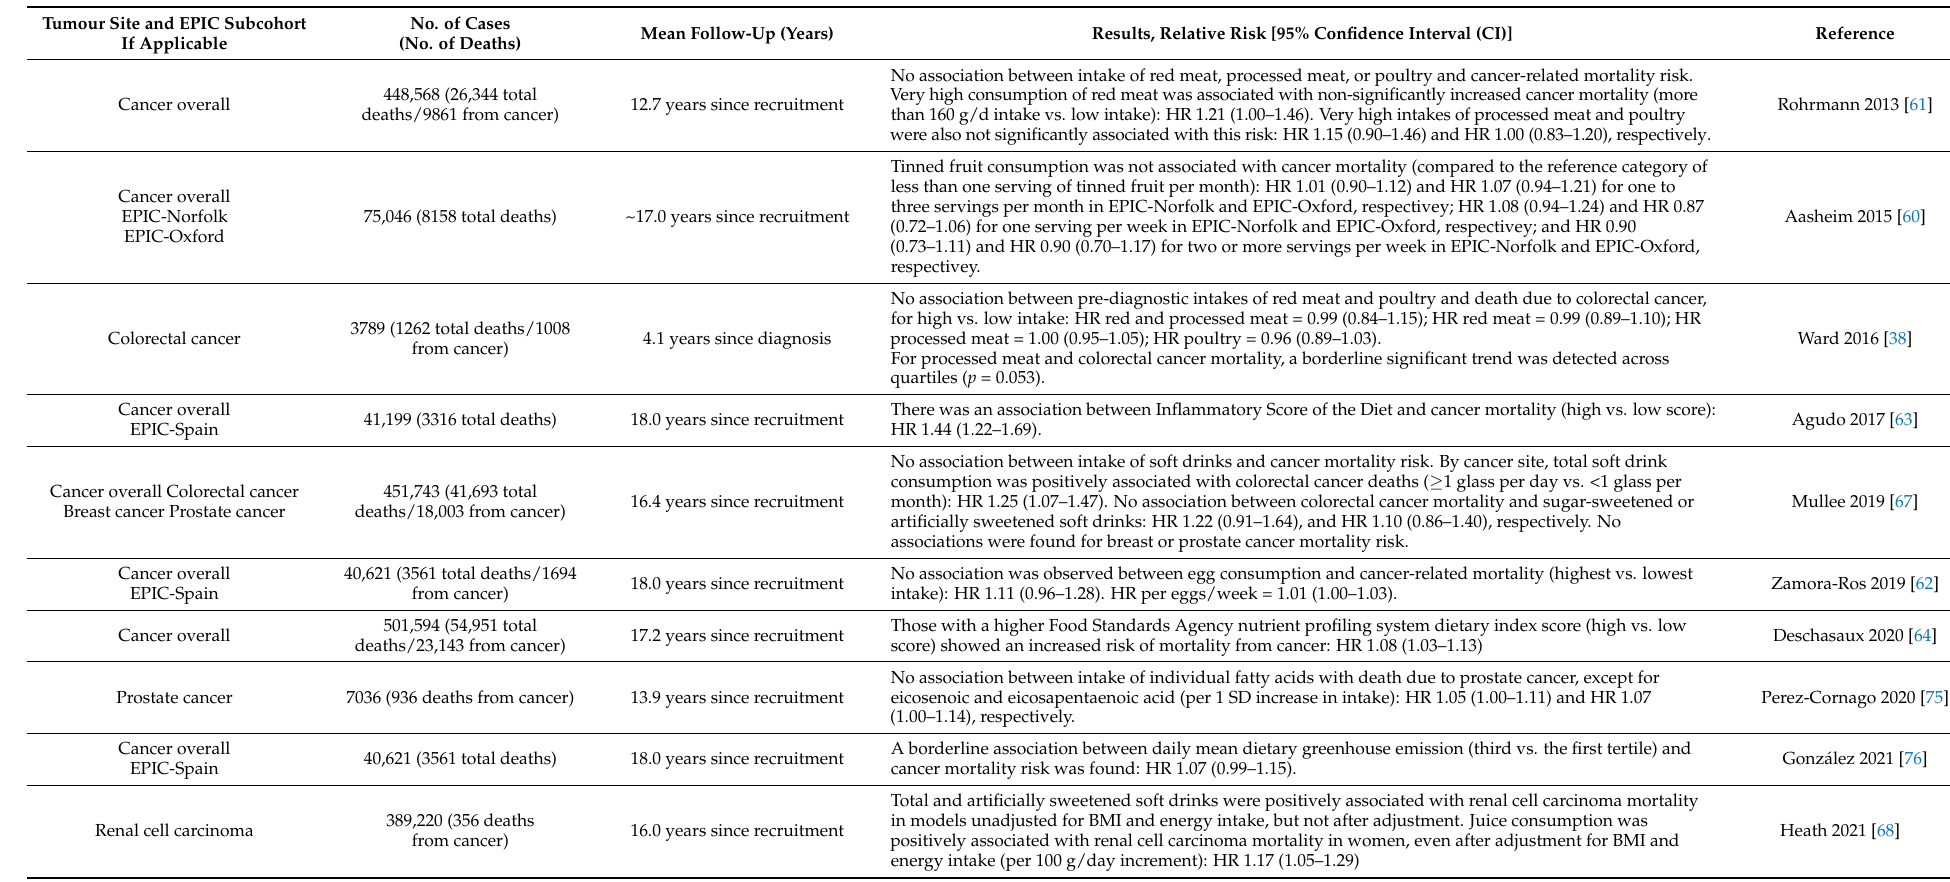
Table 3. Dietary factors investigated as potential risk factors for cancer mortality in the EPIC